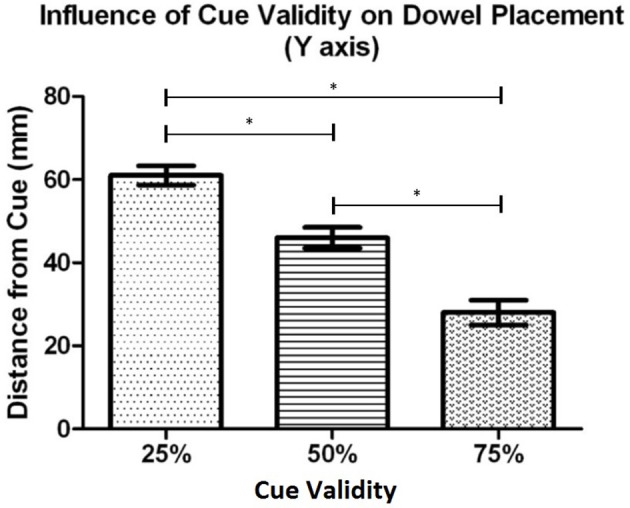
Experiment 3b: Mean distance that the dowel was placed from the cued location along the X axis (left and right space) for each cue validity condition. Error bars represent the standard error of the mean. The * indicates a statistically significant difference.